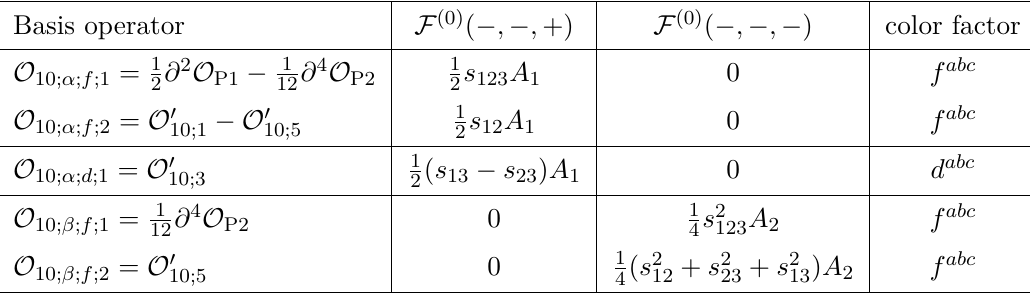
Table 5 . Final basis operators at dimension 10.